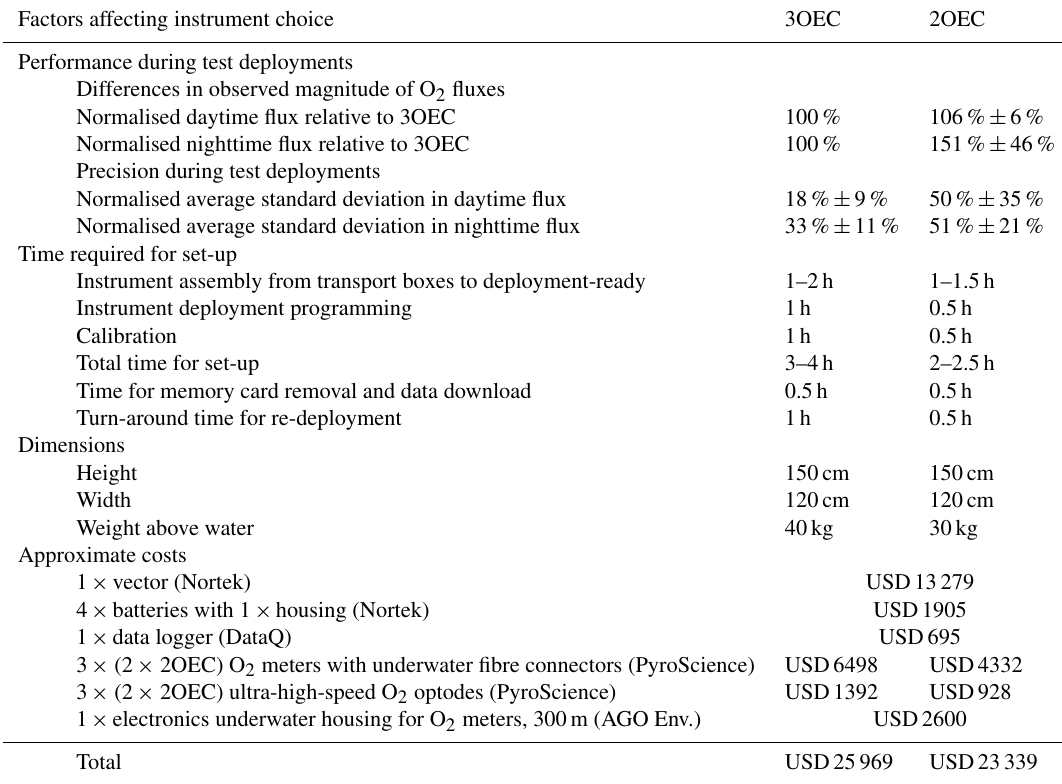
Table 1. Comparison of 3OEC and 2OEC key characteristics. Approximate costs as of August 2021. Not included are costs for support frame (custom made) and additional sensors (e.g. light, temperature, same for both